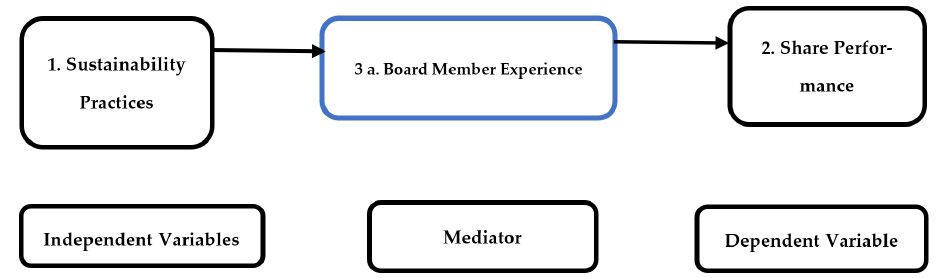
Figure 1. Research framework. Source: Researcher-Generated.